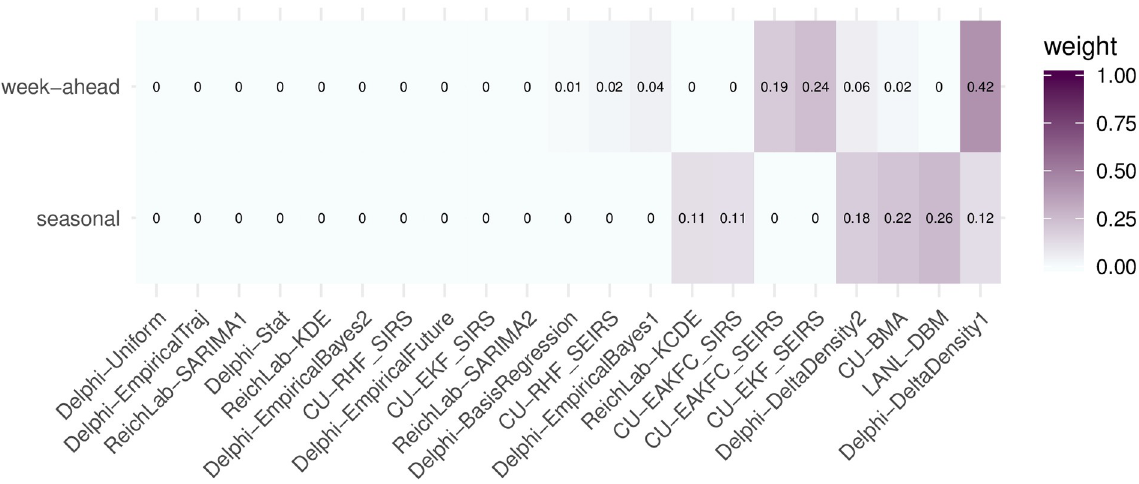
Fig 3. Component model weights for the FluSight Network Target-Type Weights ( FSNetwork-TTW ) ensemble model in the 2017/2018 season. Weights were estimated using cross-validated forecast performance in the 2010/2011 through the 2016/2017 seasons.